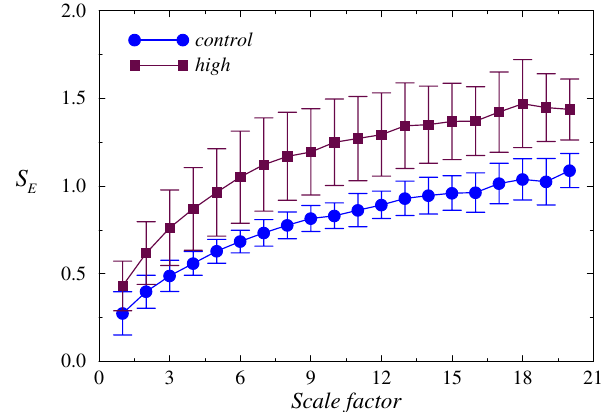
Fig. 3. The dependencies of SampEn from the scale factor are distinguished between the control recordings and data related to a late stage of gastric tumor (high level of the °uorescence signal), especially for large scale factors.